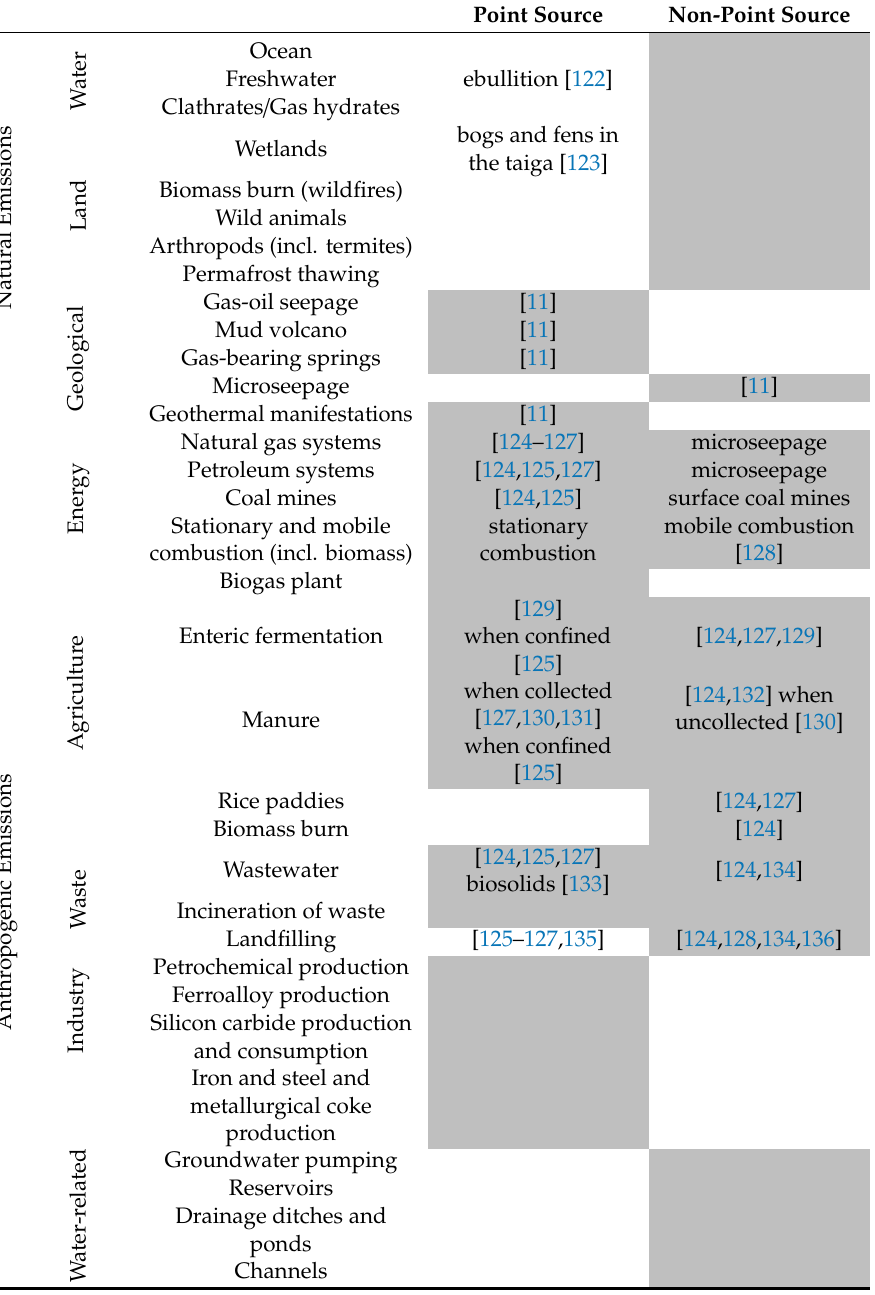
Table 4. Categorization into point and non-point sources, including literature using the terms for the specific category. Grey indicates it applies considering the global perspective, white indicates it does not apply considering the global